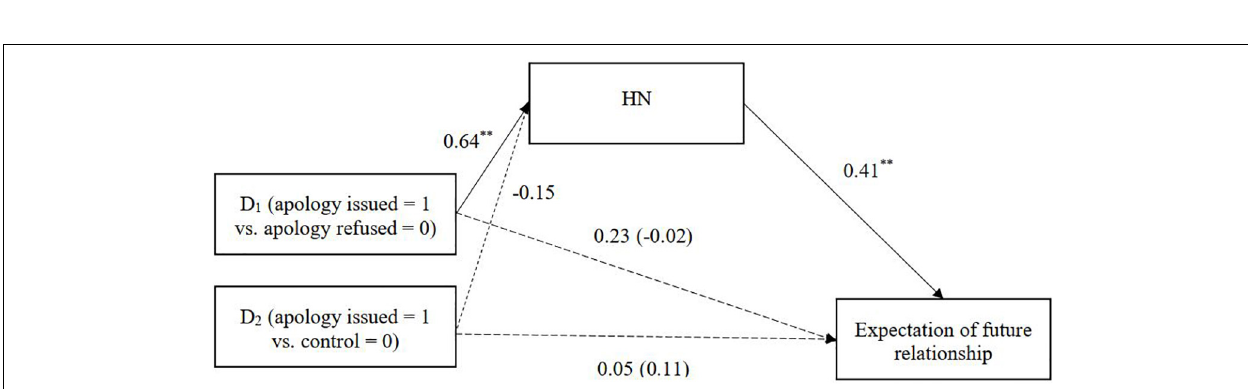
Frontiers in Psychology |